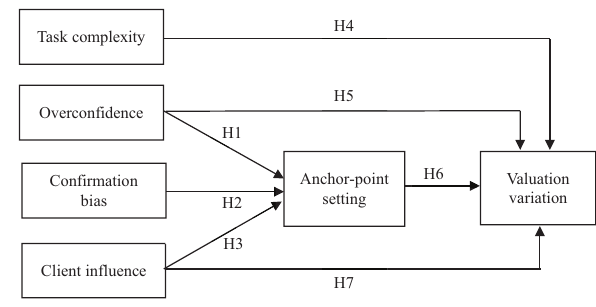
Figure 1. The research